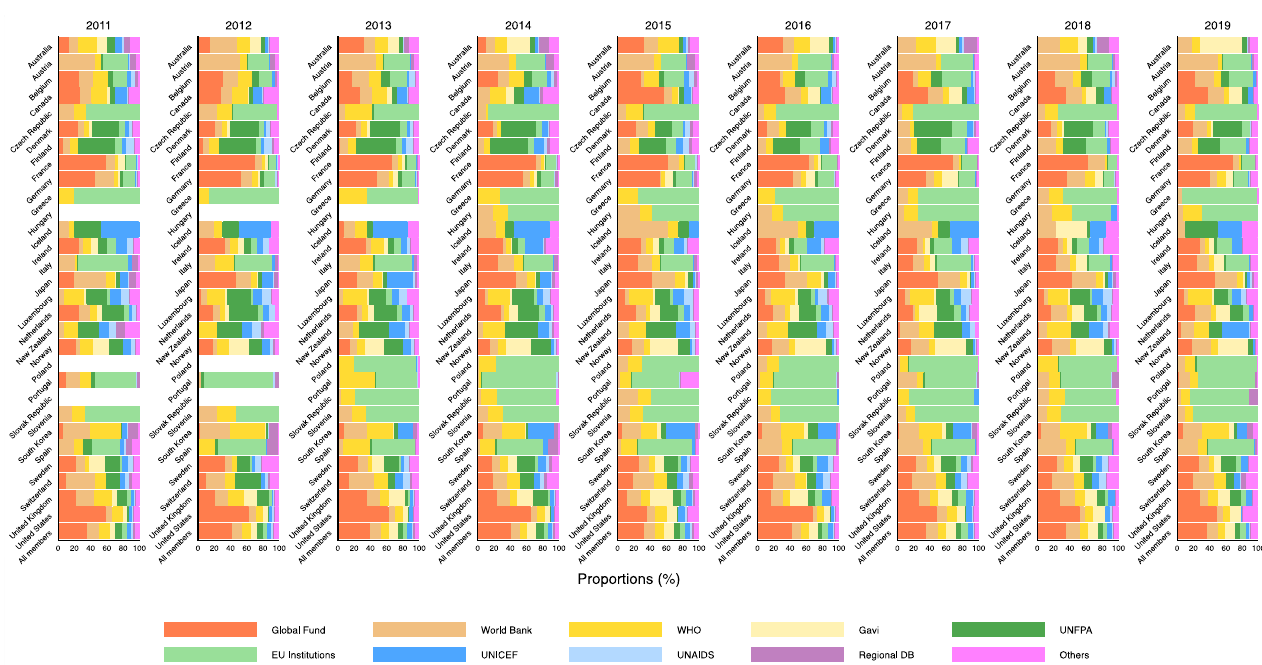
Figure 4. Estimated DAH from all the 29 DAC member countries, channelled through multilateral agencies, 2011–2019. DAH: development assistance for health; DAC: Development Assistance Committee; Global Fund: The Global Fund to Fight AIDS, Tuberculosis and Malaria; WHO: World Health Organization; Gavi: Gavi, The Vaccine Alliance; UNFPA: United Nations Population Fund; EU Institutions: Institutions of the European Union; UNICEF: United Nations Children’s Fund; UNAIDS: Joint United Nations Programme on HIV/AIDS; Regional DB: regional development banks.